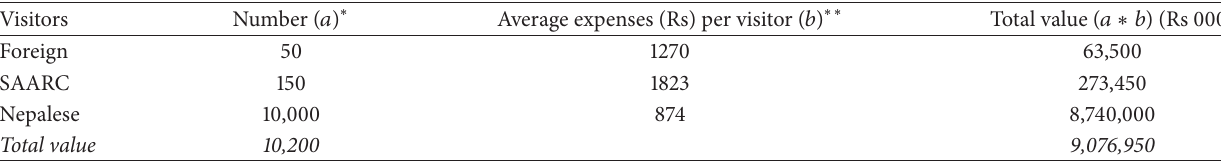
Table 7: Value of recreation services.